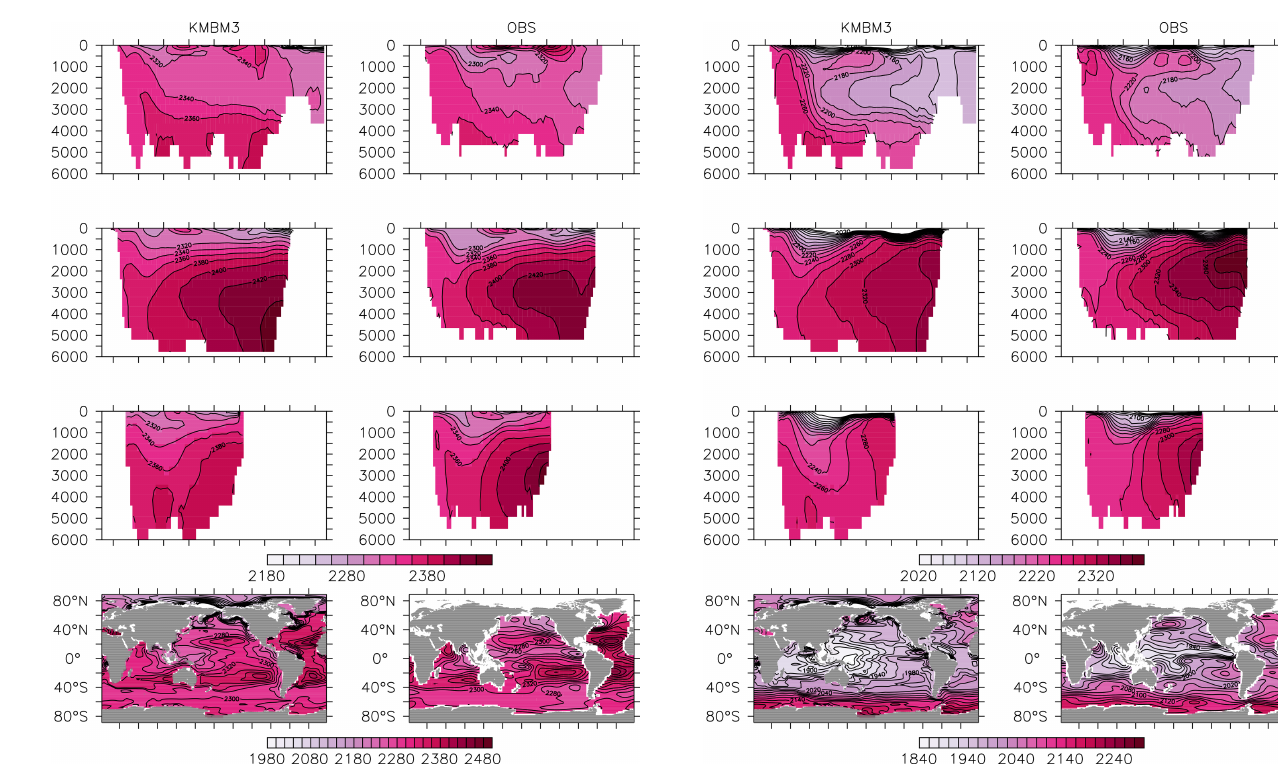
Figure 10. Model (left column) year 2014 alkalinity (µmolkg − 1 ) averaged by basin compared to GLODAP (right column; Key et al., 2015; Lauvset et al., 2016). Regions are as follows: Atlantic (top row), Pacific (second row), Indian (third row) and global surface (bottom row).